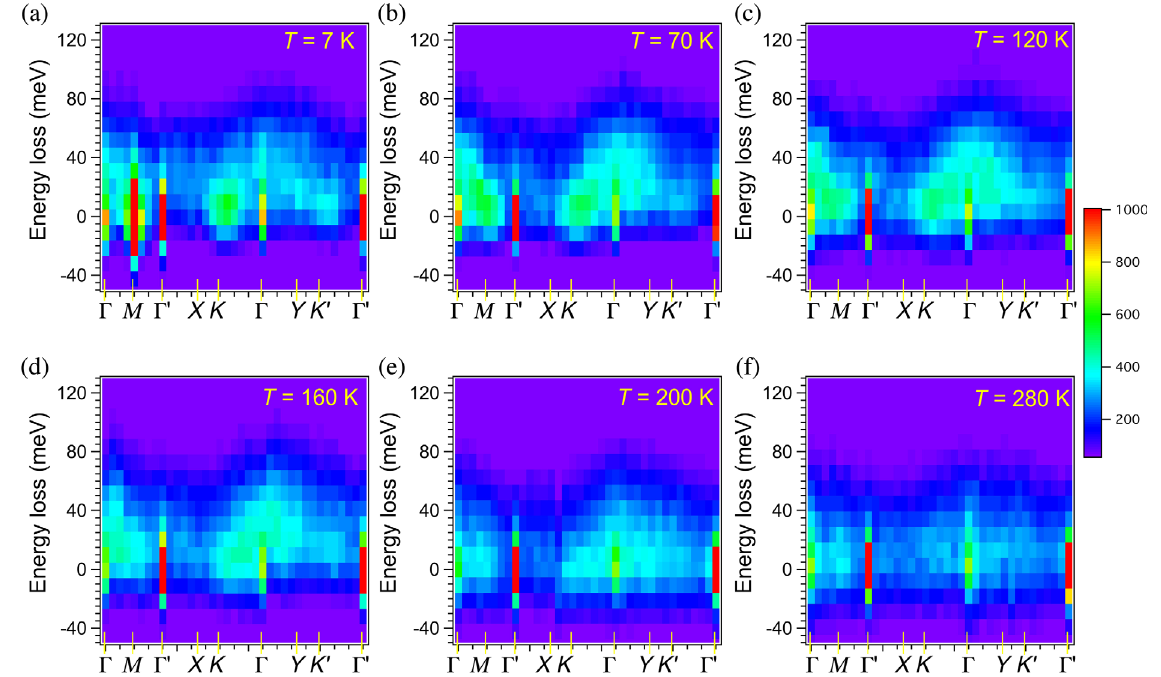
FIG. 7. Temperature evolution of magnetic excitation spectra. (a) T ¼ 7 K. (b) T ¼ 70 K. The magnetic Bragg peak at the M disappears, indicating disappearing zigzag correlations. Spectral intensities fill in between Γ and all first Brillouin zone symmetric points ( M , K , K 0 , and Y ), connecting the high-energy feature at the Γ to the low-energy features at the M , K , and Y . This trend becomes more pronounced at (c) T ¼ 120 K and (d) T ¼ 160 K. (e) T ¼ 200 K. Spectral intensities move toward lower energy. (f) T ¼ 280 K. The RIXS intensity over the whole Brillouin zone substantially